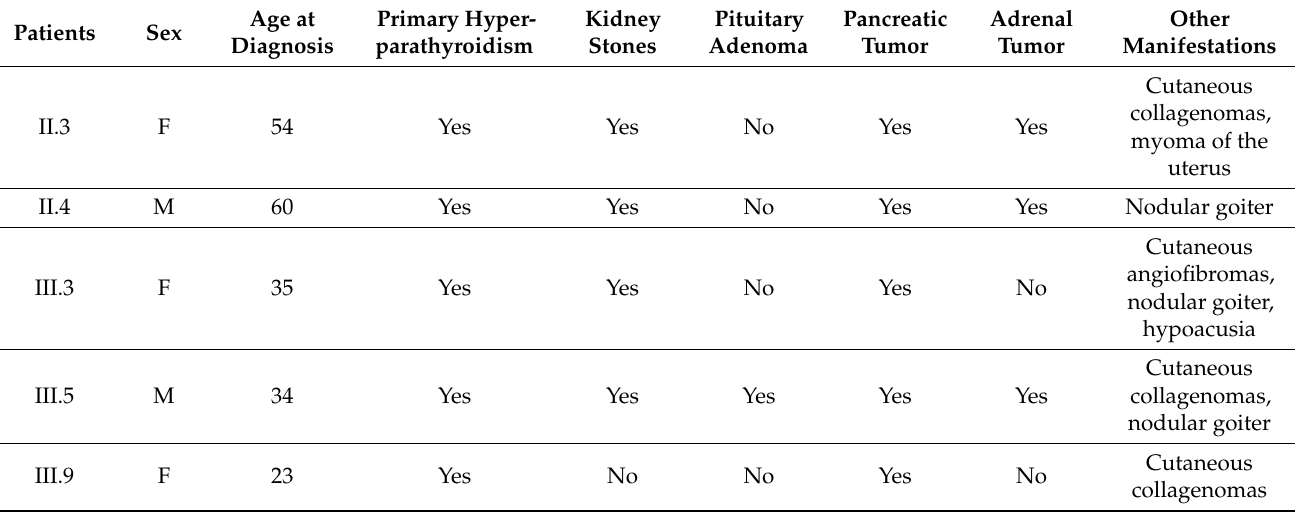
Figure 1. Pedigree of a family with multiple neuroendocrine neoplasia type 1 (MEN1) syndrome. Generations available for the study are indicated by Roman numerals I–IV. Black symbols: affected subject. Grey symbol: MEN1 variant carrier. Squares indicate male; circles indicate female; the arrow indicates the index patient. The horizontal line in circles and squares indicates a negative MEN1 variant gene test, while a diagonal line in the square indicates that the patient was not alive at the time of the study. Table 1. Clinical features of the proband and relatives.